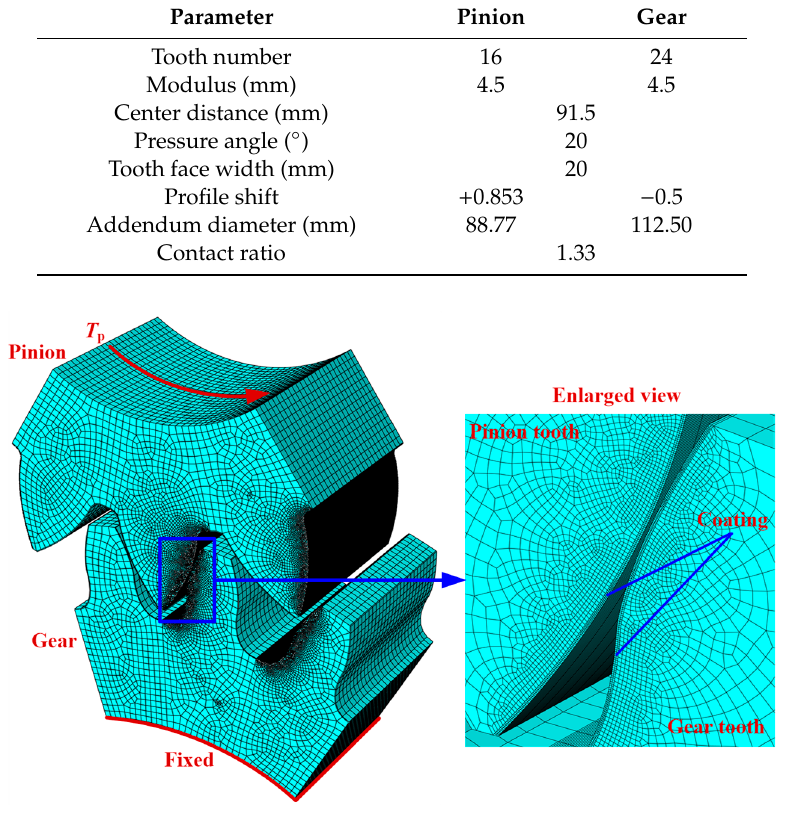
Table 1. Geometrical parameters of the gear pair.